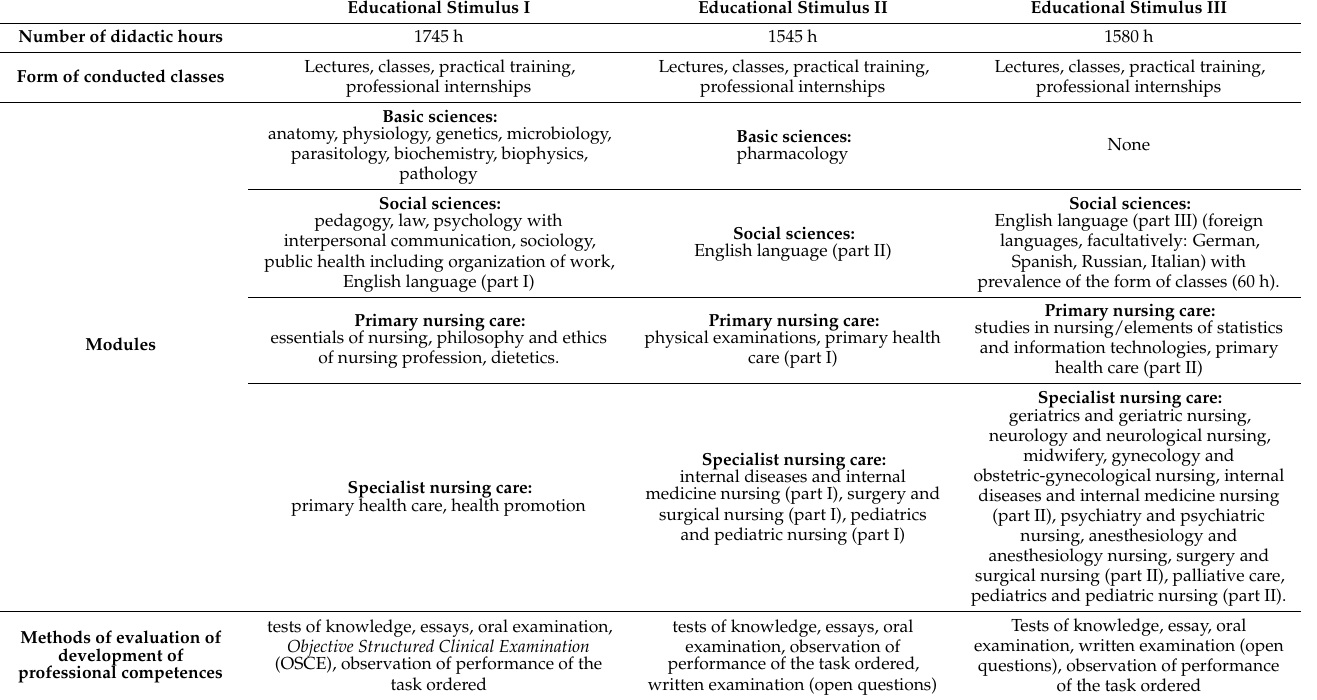
Table 1. Characteristics of the selected features of the curriculum in